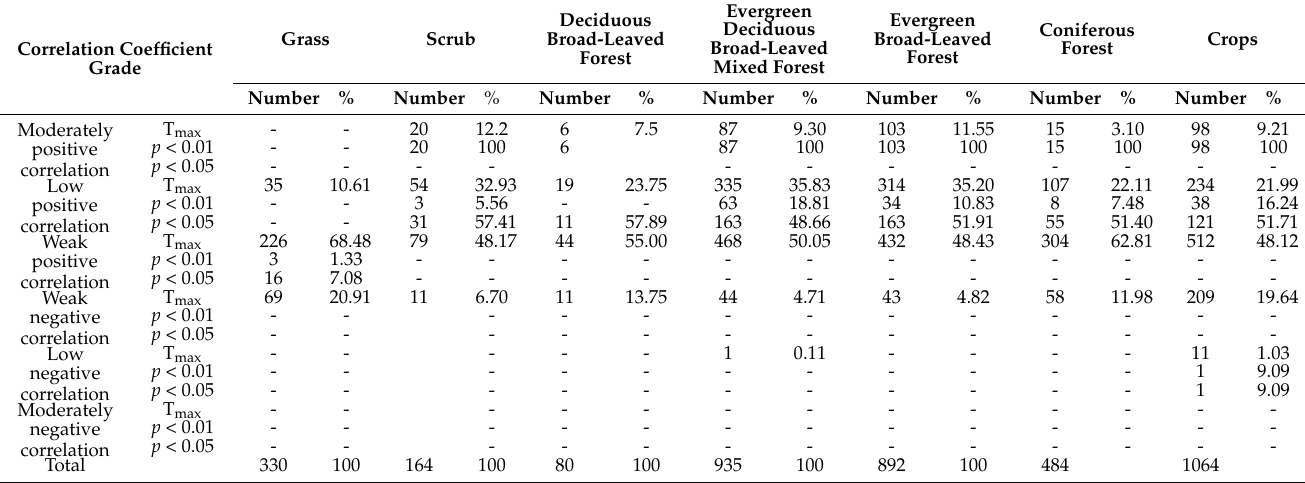
Table 2. Numbers and t -tests of grids with different correlation coefficients between different vegeta- tion types and T max in Qinba